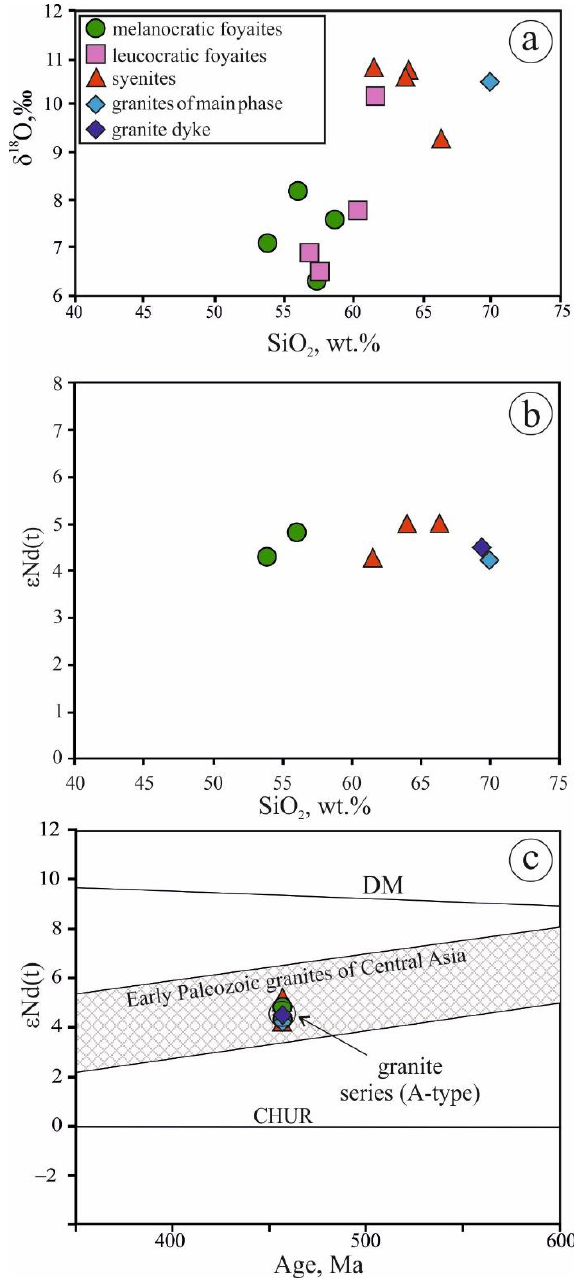
Figure 10. ( а ) δ 18 О (‰) vs. SiO 2 (wt.%) diagram for the studied alkali feldspars; ( b ) εNd(t) vs. SiO 2 (wt.%) diagram; and ( c ) εNd(t) vs. age (Ma) diagram for the Saibar rocks in comparison with granite series (A-type) of the Kuznetsk Alatau and Batenevskiy Ridge of the Altay-Sayan fold belt [48] and the Early Paleozoic granites of Central Asia [75–77]. The Nd isotopic composition was investigated in two samples of melanocratic foyaites, three samples of syenites, and two samples of granites (Table 3). εNd(t) values were calculated using the U-Pb age of zircon (457 Ma) obtained from the study of melanocratic foyaites. All samples are characterized by positive εNd(t) values from +4.1 to +5.0. The narrow range of εNd(t) values in the Saibar rocks characterizes a homogeneous magma source. The εNd(t) values in the analyzed samples do not correlate with the SiO 2 content (Figure 10b).